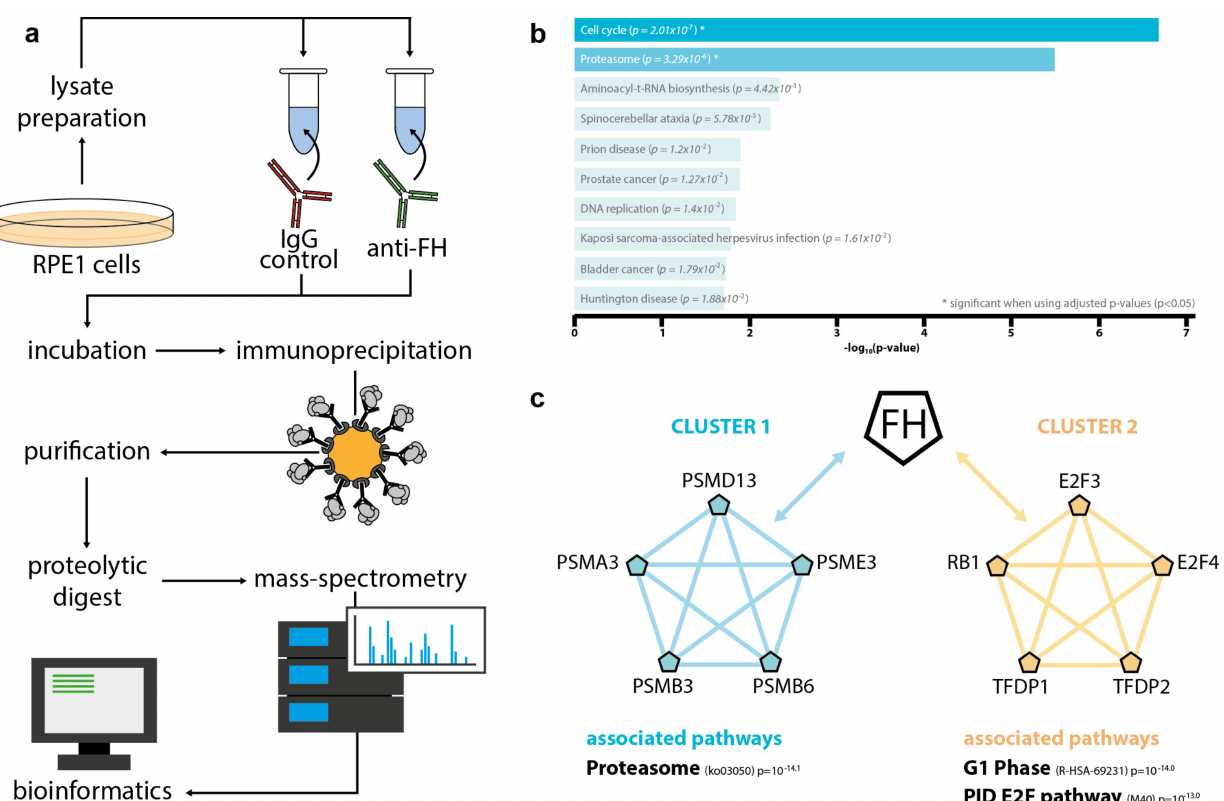
Figure 4. Intracellular FH interacts with factors associated with the proteasomal pathway and the RB1/E2F pathway. The hTERT-RPE1 lysates were incubated with either unspecific immunoglobulin G (control) or anti-FH antibody, and immunoprecipitation was perfromed using protein-G labeled agarose beads. Proteins were purified and digested with trypsin before mass-sprectrometric analysis. ( a ) Experimental workflow. ( b ) Gene-ontology analysis using Enrichr [51] identified the proteasomal pathway and cell cycle as the most represented pathways. ( c ) Protein-protein interaction network analysis via Metascape [52] defined two clusters of FH interacting factors. Cluster 1 included members of the 20S/26S proteasome (PSMD13, PSME3, PSMB6, PSMB3, PSMA3), cluster 2 included factors involved in RB1/E2F signaling and cell-cylce control (E2F3, E2F4, TFDP2, TFDP1,